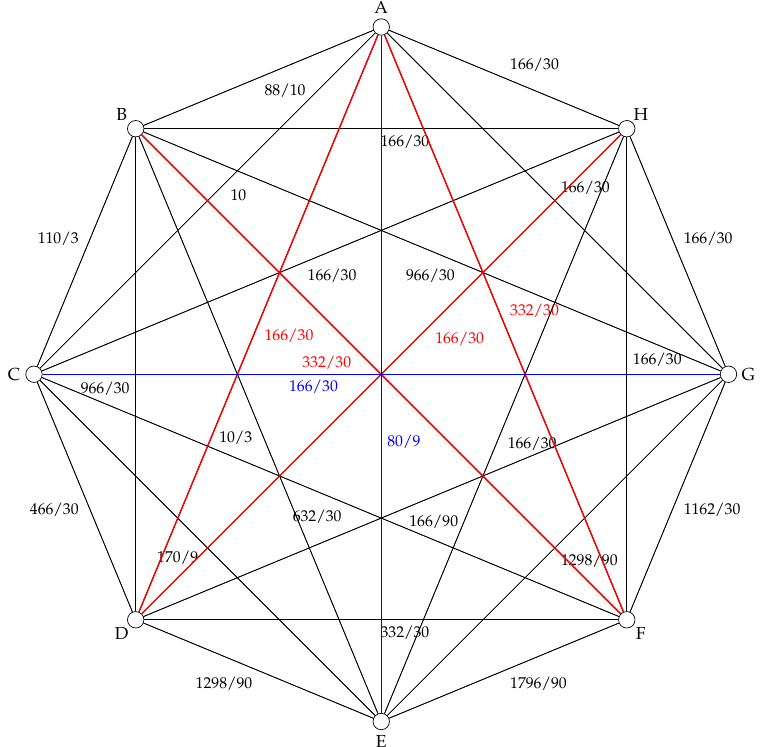
Figure 1. The graph that is associated to all of the possible regulations for the communal and the corresponding